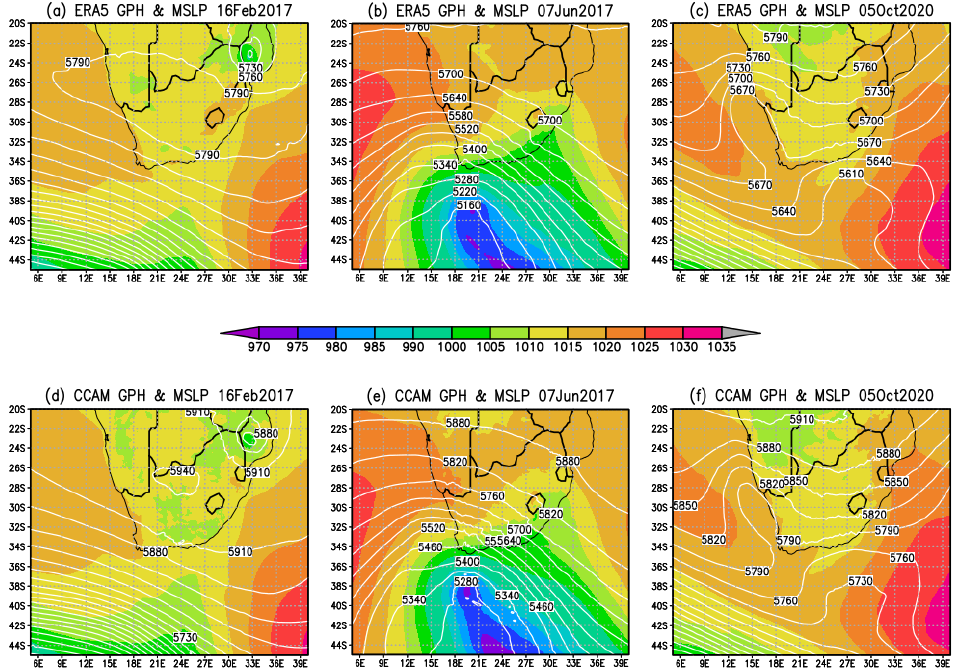
Figure 3. The ERA5 reanalysis sea level pressure in shaded colors and 500 hPa geopotential heights in white labeled contours for ( a ) 16 February 2017, ( b ) 7 June 2017, ( c ) 5 October 2020, and the same variables for CCAM MN9km ( d ) 16 February 2017, ( e ) 7 June 2017 ( f ) 5 October